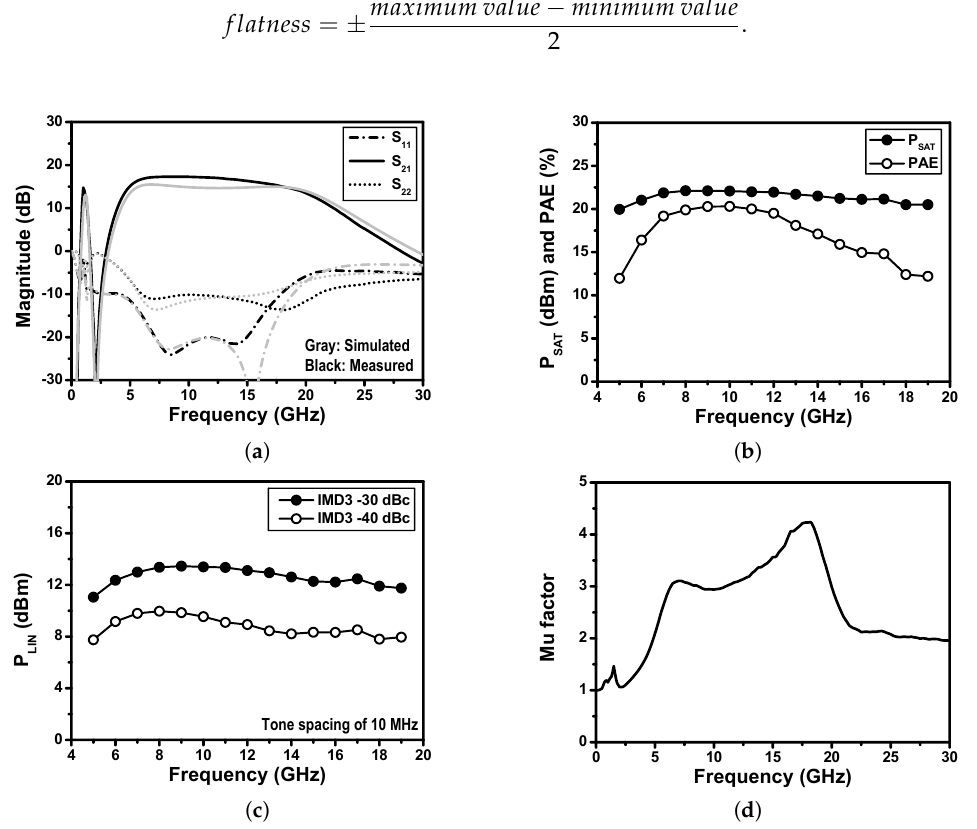
Figure 7. Experimental results of the proposed 6–18 GHz GaAs pHEMT broadband PAIC, ( a ) small-signal S-parameters, ( b ) saturated output power and PAE, and ( c ) linear output power with an IMD3 of − 30 dBc and − 40 dBc, ( d ) mu